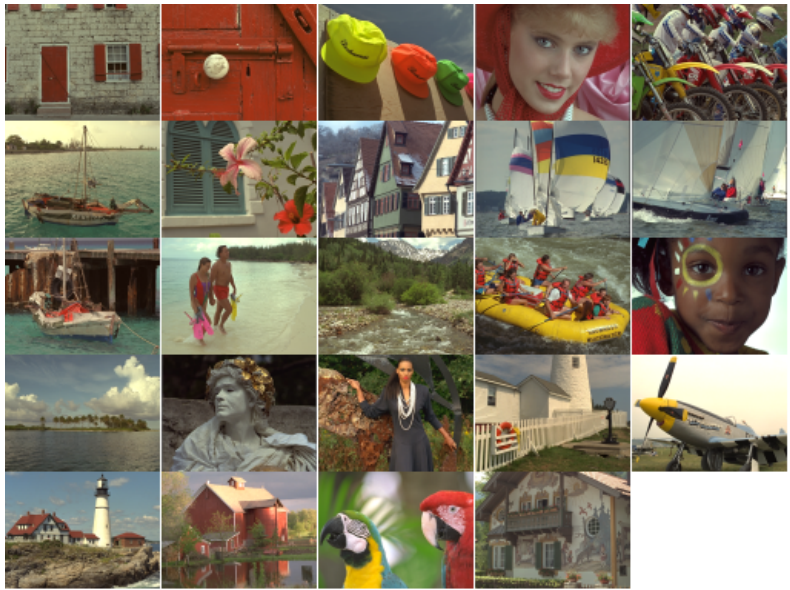
Figure 4. Set of Kodak test images. The average results obtained for both pixel and superpixel versions at different